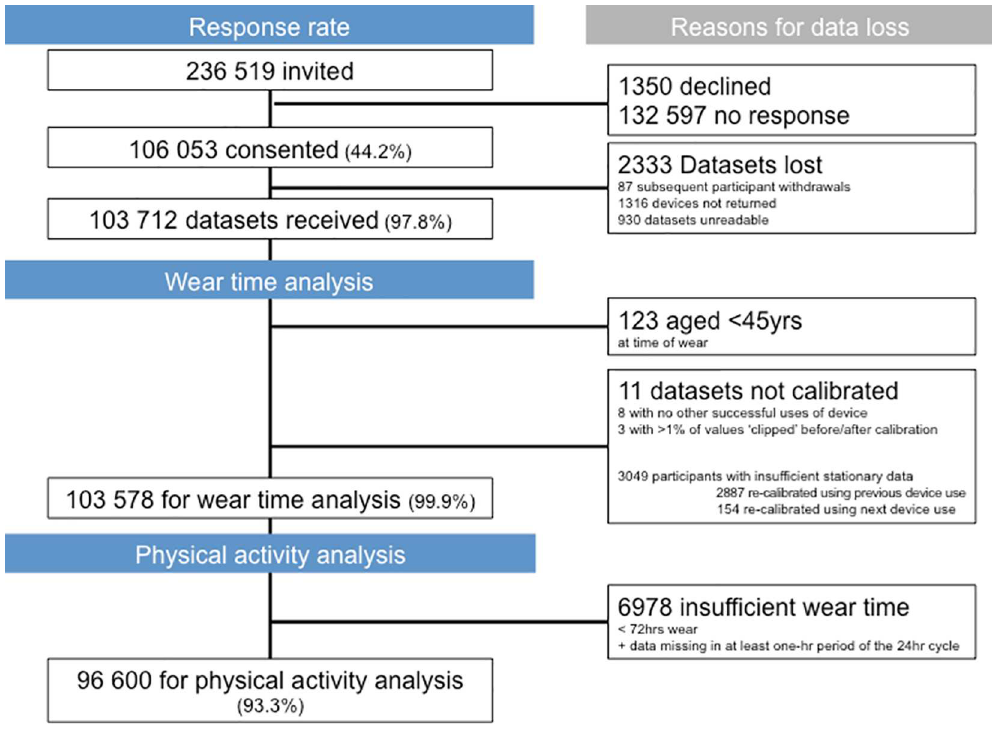
Fig 2. Participant flow chart; the UK Biobank study 2013–2015 (n =